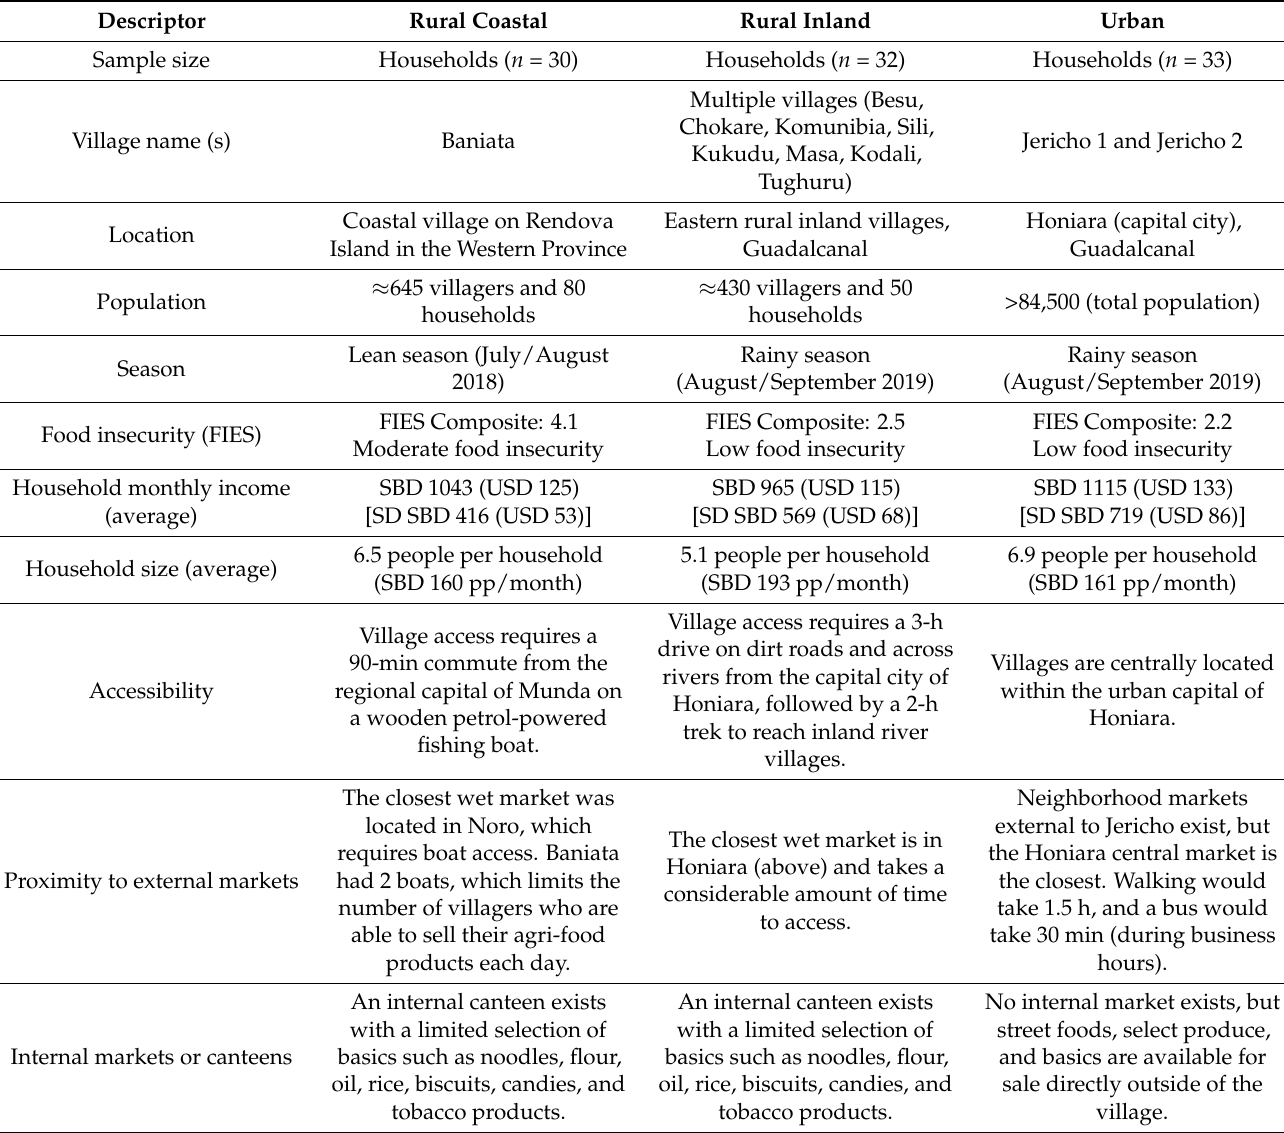
Table 1. Characteristics and food system descriptors for three geographically unique indigenous Solomon Island